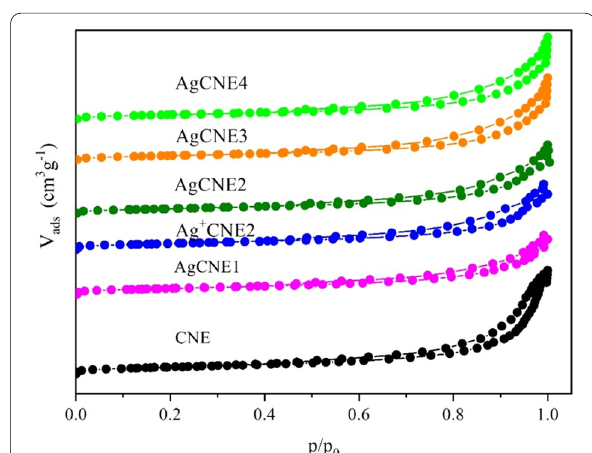
Fig. 8 Nitrogen adsorption–desorption isotherms of AgCNE nanomaterials